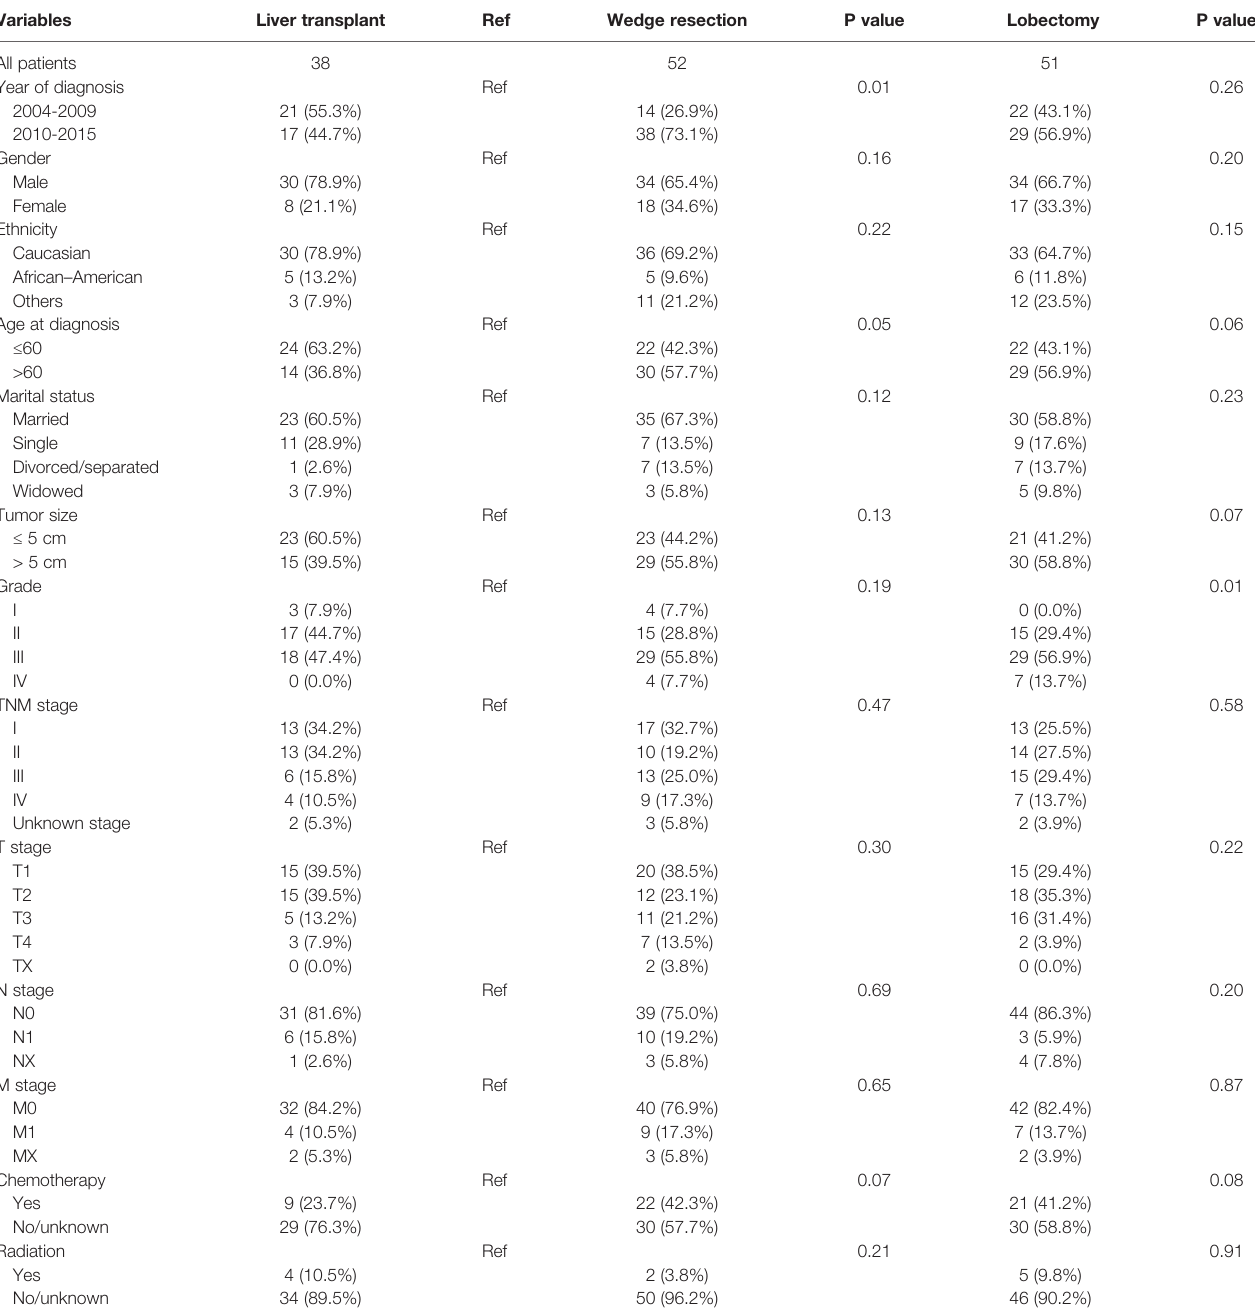
TABLE 4 | The clinical characteristics of combined hepatocellular carcinoma and cholangiocarcinoma patients undergoing speci fi c surgical